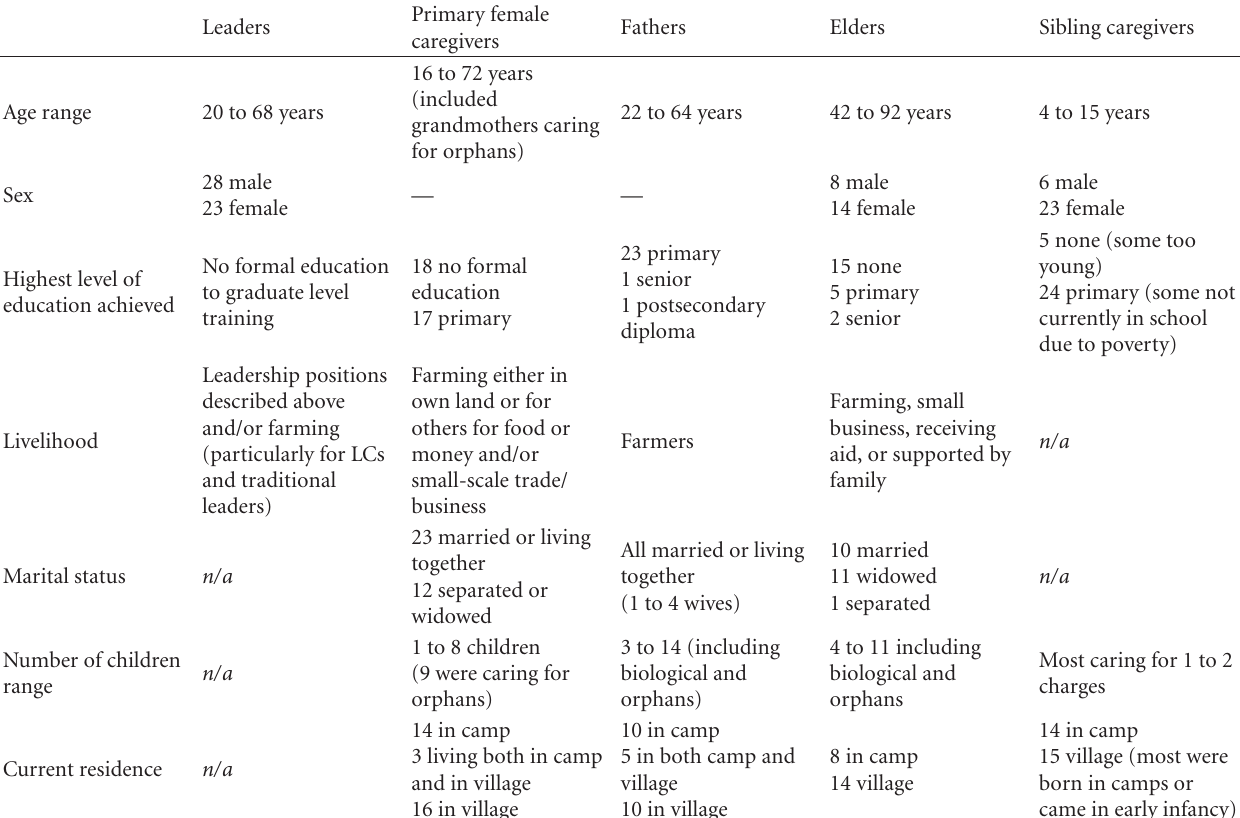
Table 2: Demographics of